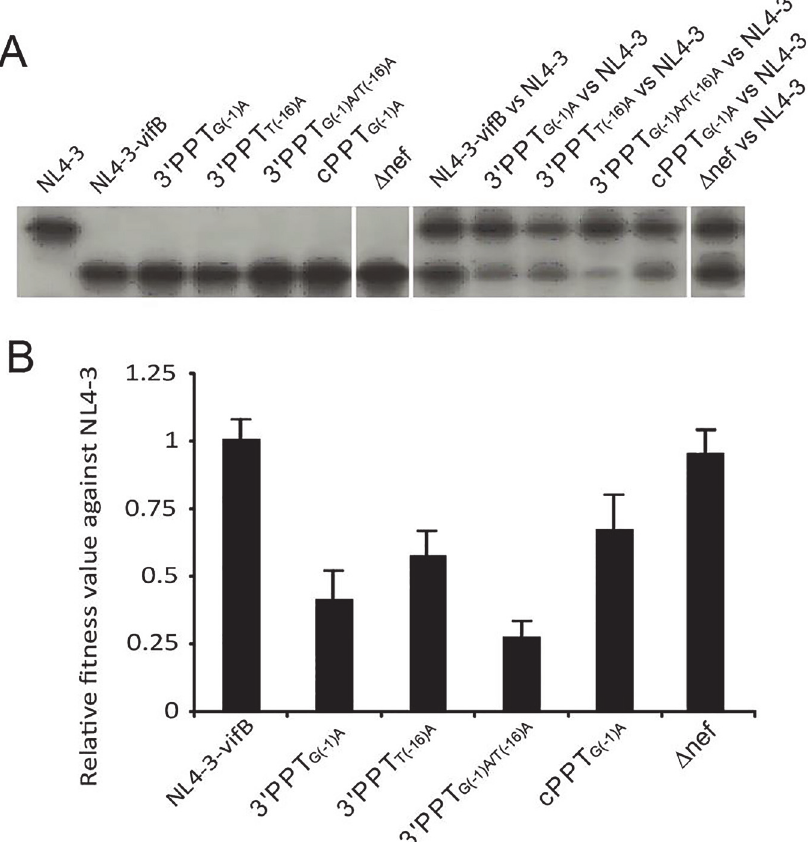
Fig 5. The influence of PPT-region mutations on viral fitness. (A) Example of heteroduplex tracking assay (HTA) gel used to measure the viral fitness of PPT Δ nef mutants. Migration of heteroduplexes produced in single or dual/competitive infections are shown on the left and right sides of the panel, respectively. (B) Relative fitness values of PPT and Δ nef mutants compared with